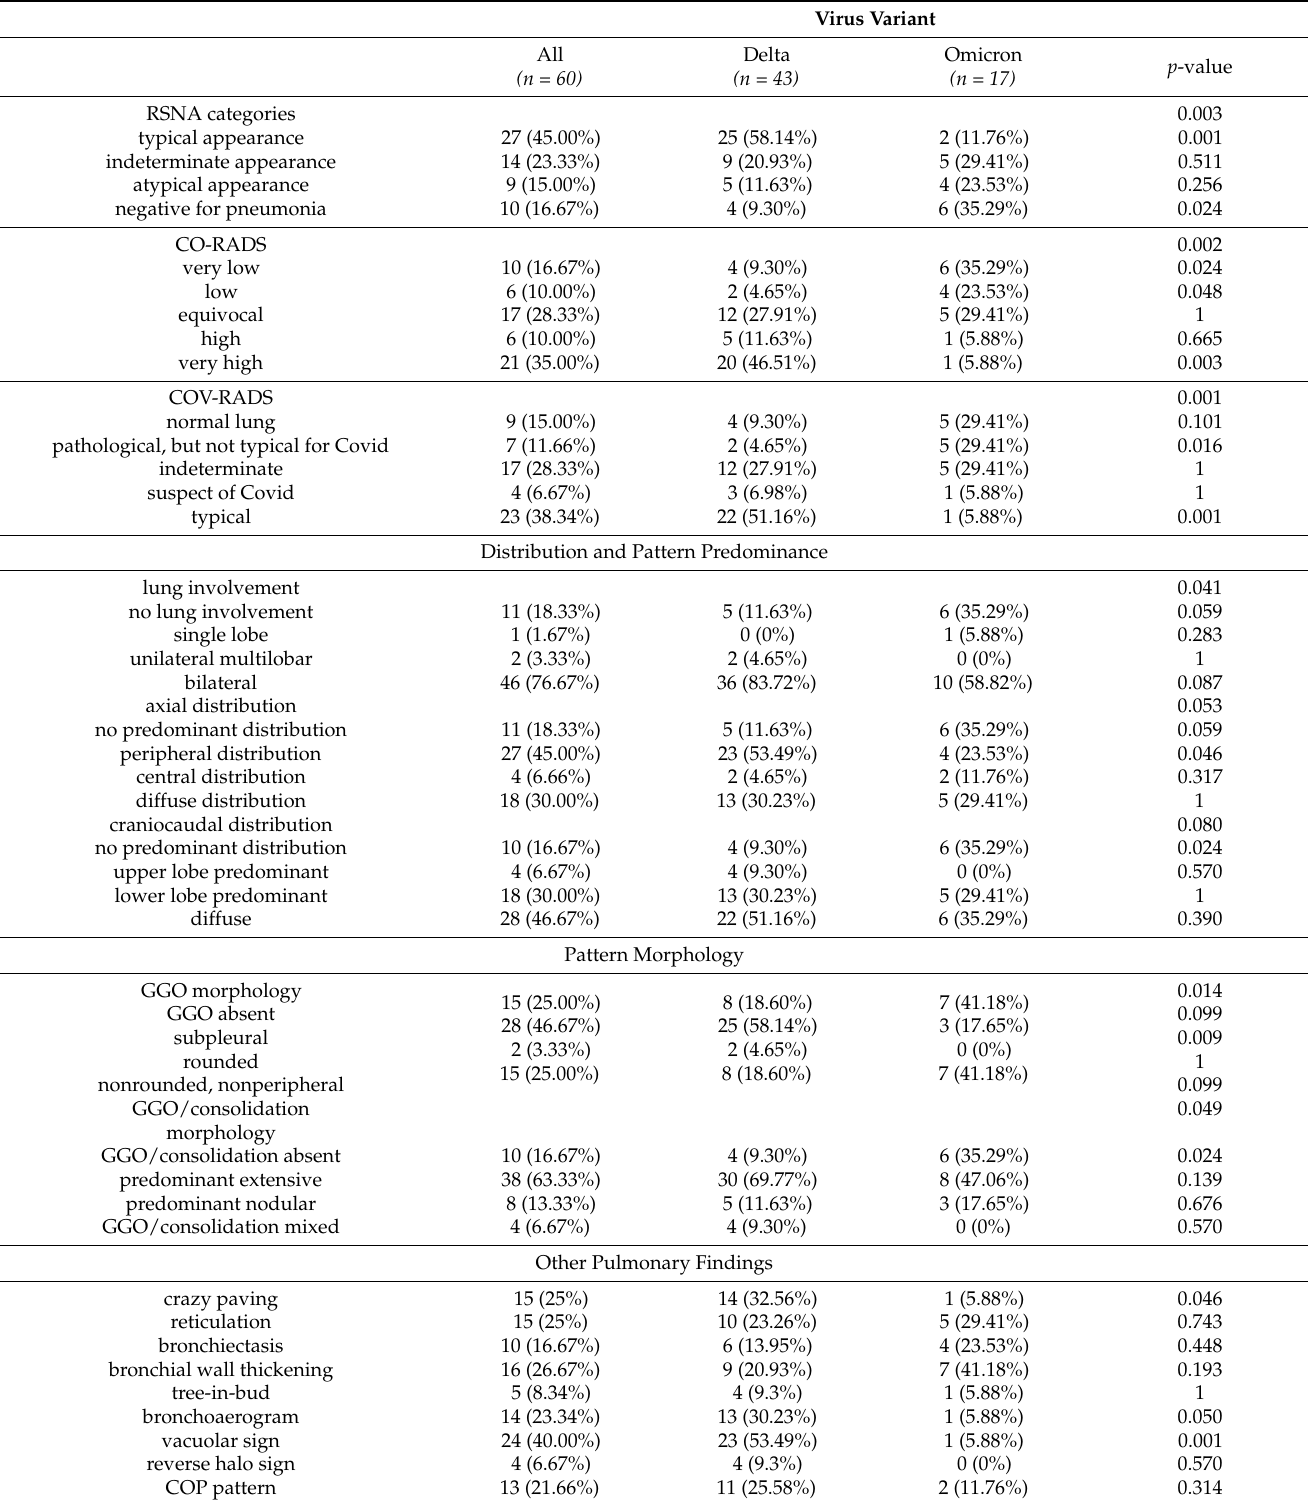
Table 2. Qualitative-scoring CT-graphic pulmonary and thoracic manifestation of COVID-19 infection according to the virus